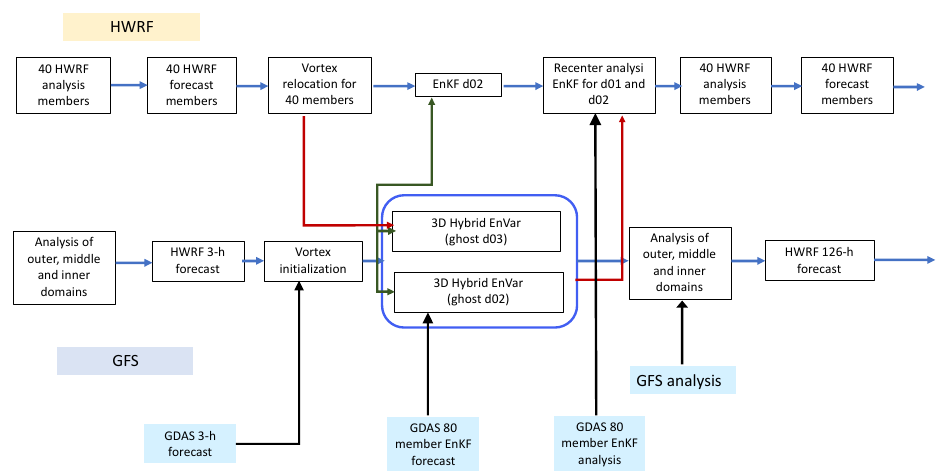
Figure 2. Flow diagram of a self-cycled HWRF hybrid variational system. Blue shaded boxes indicate components from NCEP global system (GFS).